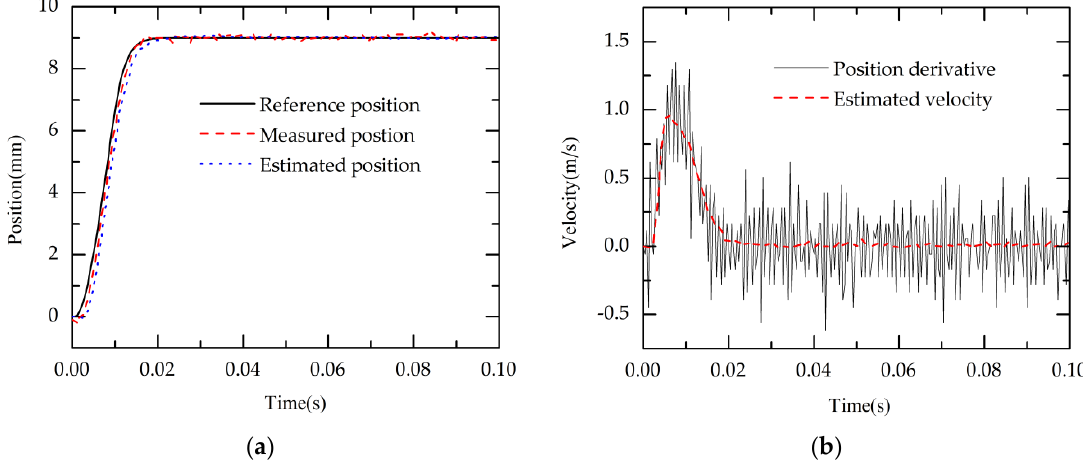
Figure 13. The structure of the control system. ADC: Analog to Digital Converter; CAP: Capture Unit.